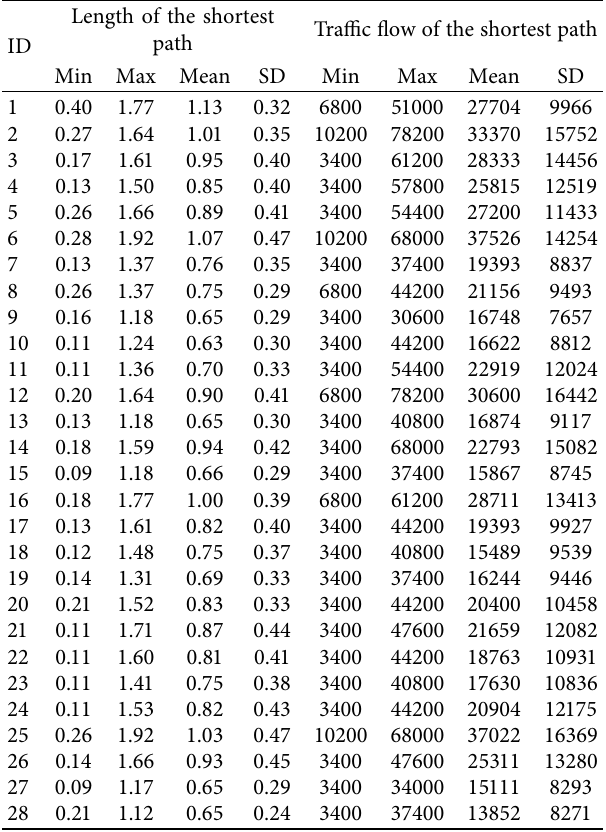
Table 1: Statistics of the shortest path and traffic